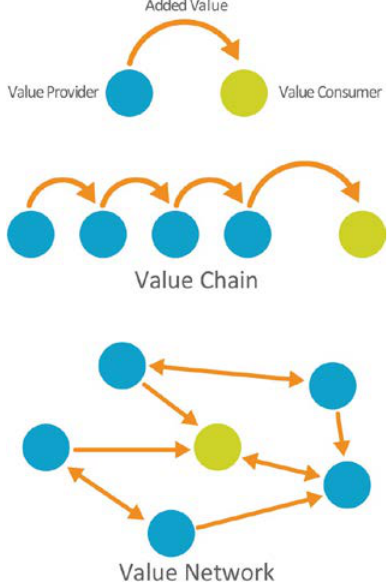
Figure 3 . General representation showing the concepts of value chains and value